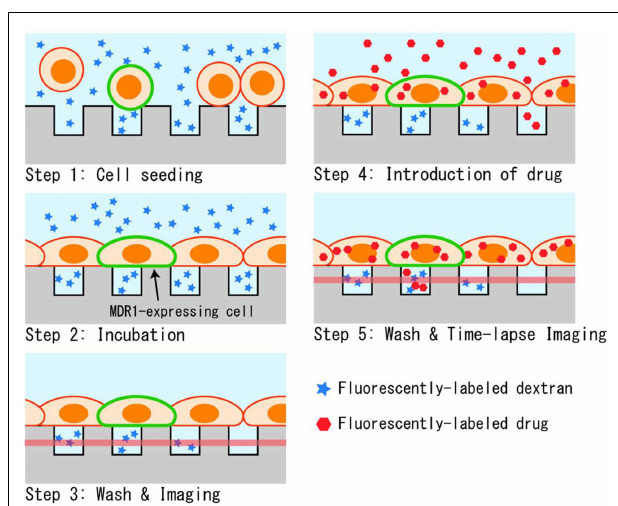
FIGURE 3 | Experimental procedure . (1) Suspended cells in dextran solution are seeded on the microchamber device. (2) Cells adhere to form a confluent layer over the microchambers. (3) Buffer above the cells is washed and the sealing of chambers was confirmed by fluorescent imaging. (4) Drug is introduced, and incorporated into cells during incubation. (5) After the second washing, the drug transported into microchambers is measured by fluorescent